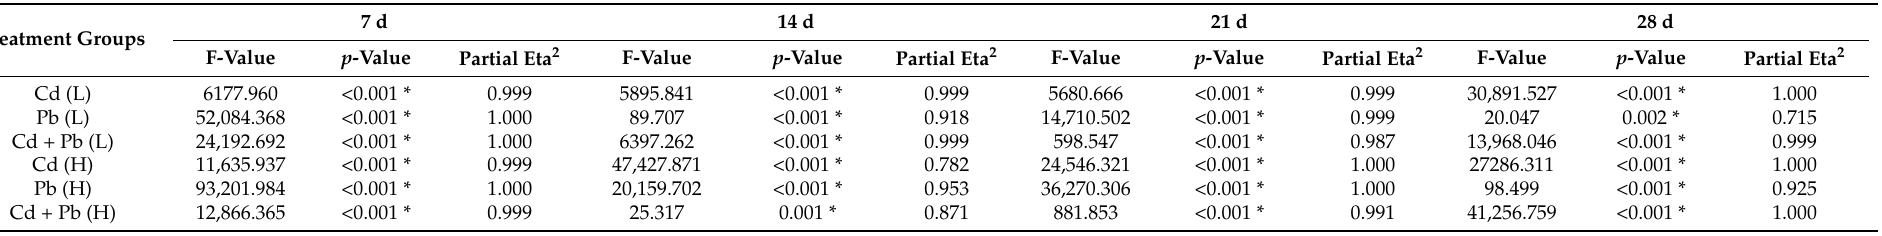
Table 1. Factorial analyses of combined effects of Cd-Pb with different concentrations in waters on IBR in the hepatopancreas of M. nipponense during different periods. Treatment